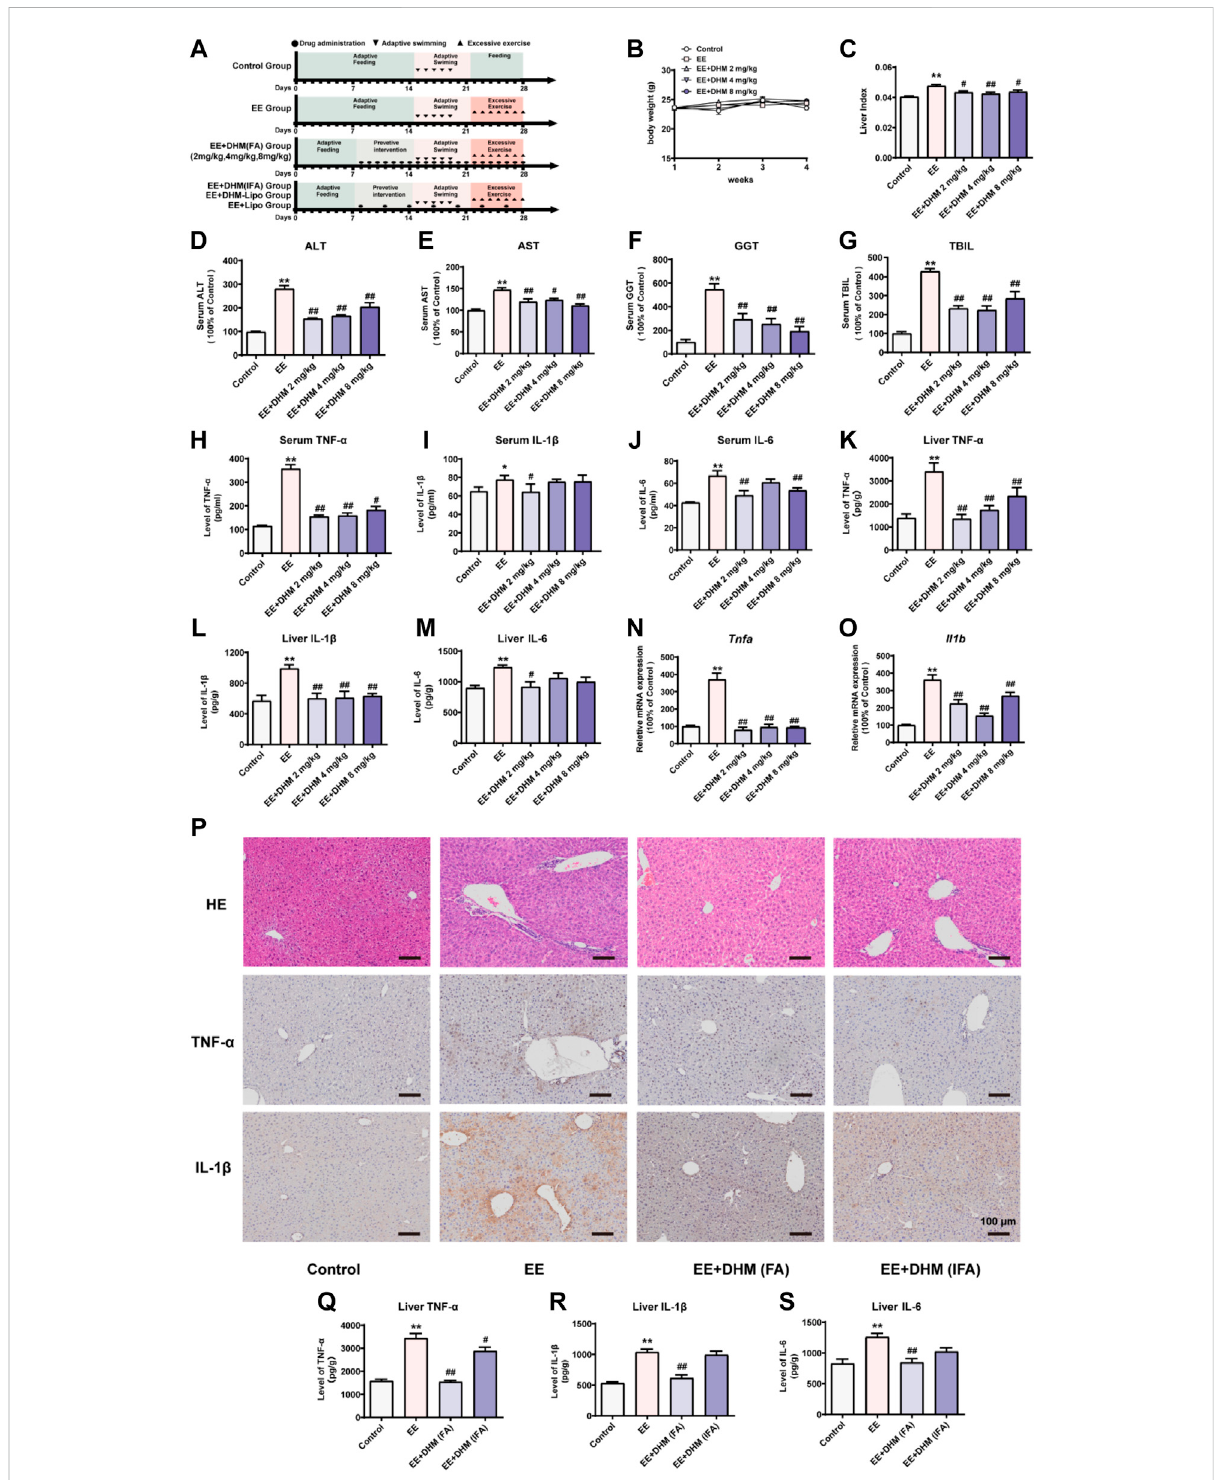
FIGURE 1 DHM administration ameliorated EE-induced liver in fl ammation and its ef fi cacy was in fl uenced by the dosing interval (A) Schematic diagram of the experimental design (B) The body weights of the mice were recorded (C) The liver index represents the ratio of liver weight to body weight (D – G) Serum levels of ALT, AST, GGT, and TBIL were examined (H – M) The expression of the in fl ammatory cytokines TNF- α , IL- 1 β , and IL-6 in mouse serum samples (H – J) and mouse liver samples (K – M) was examined by ELISA (N – O) The mRNA expression levels of TnfaandIl1bweredetectedbyqRT – PCR (P) Liver in fl ammationwasexaminedbyH&EandIHC for TNF- α andIL-1 β (Q – S) Theexpressionof the in fl ammatory cytokines TNF- α , IL-1 β , and IL-6 in mouse liver samples was examined by ELISA. Data are presented as the mean ± SEM ( n = 5). * p < 0.05, ** p < 0.01, compared to the control group; # p < 0.05, ## p < 0.01, compared to the EE group. Scale bar, 100 μ